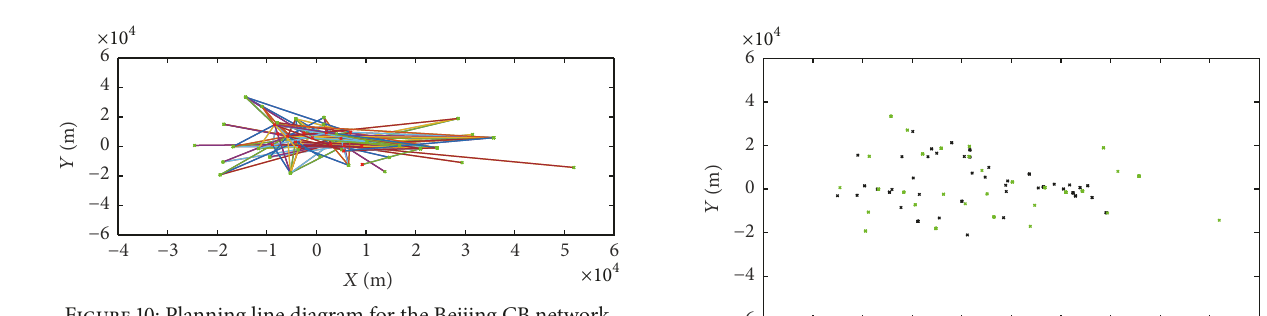
Figure 10: Planning line diagram for the Beijing CB network.